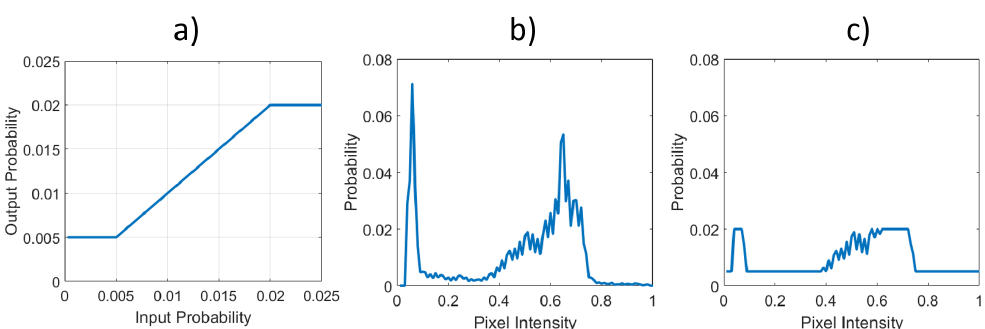
Figure 4. Visualising the piece-wise linear activation function’s impact on a discrete histogram vector. ( a ) A linear function between 0.005 and 0.02 (that clips to the boundary values for inputs outside this range). ( b ) An arbitrary histogram. ( c ) The histogram from ( b ) after it has been modified by ( a